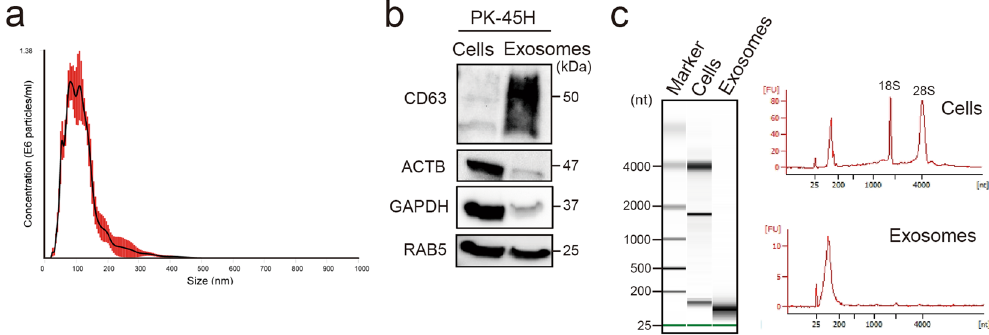
Figure 1. Detection of exosomes and exosomal proteins and RNAs released from PK-45H cells. ( a ) Detection of particles in culture supernatants of PK-45H cells. The horizontal axis represents the particle size (nm), whereas the vertical axis represents the particle concentration ( × 10 6 particles/mL). Red bar represents the standard errors of means. The mean particle size is 115 ± 9.1 nm. ( b ) Detection of CD63, ACTB, GAPDH and RAB5 proteins in the exosomes released from PK-45H cells and the cellular proteins by Western blotting. CD63, a tetraspanin family member, known as the exosomal marker, was detected in the exosomal proteins. Full- length blots are present in Supplementary Fig. S2. ( c ) Detection of exosomal RNAs released from PK-45H cells and the cellular RNAs using the Agilent 2100 Bioanalyzer. The peak detected 25 nucleotides (nt),